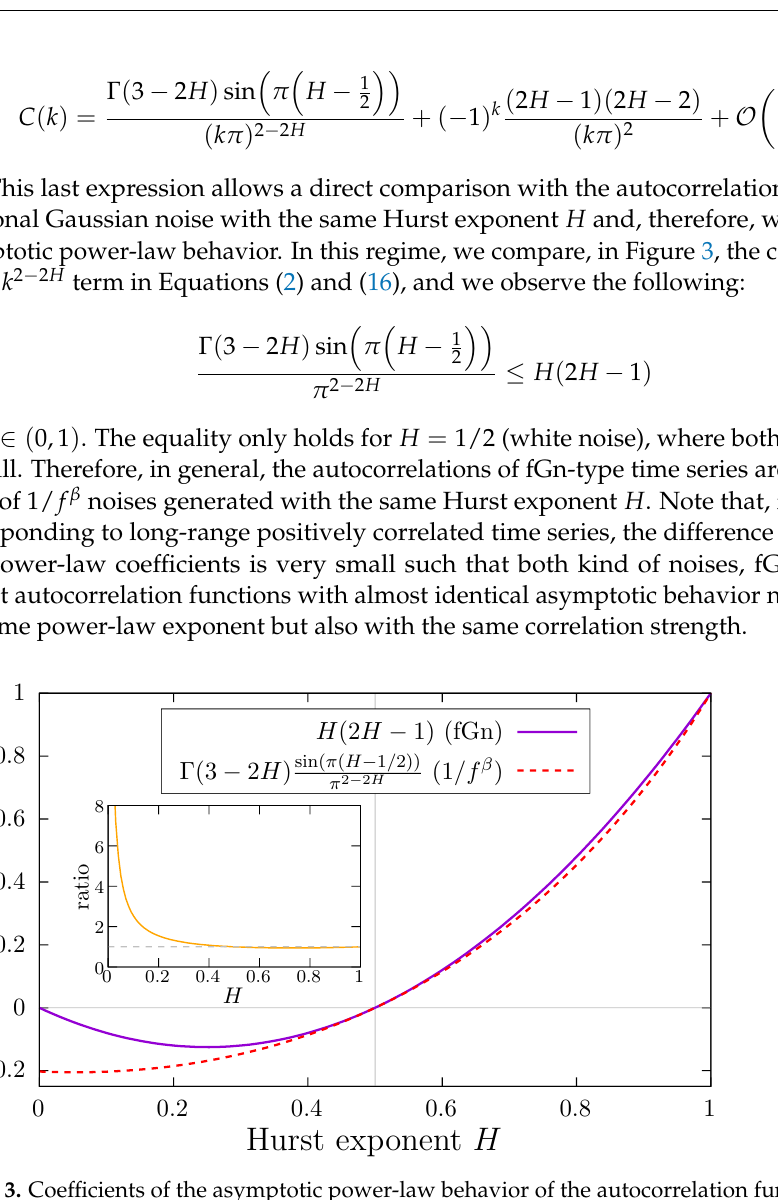
Figure 3. Coefficients of the asymptotic power-law behavior of the autocorrelation functions of fGn (solid line) and 1/ f β noises (dashed line) as a function of the Hurst exponent H . Inset: The ratio of the power-law coefficients of 1/ f β noises over fGn also as a function of H . The horizontal dashed line corresponds to a ratio equal to